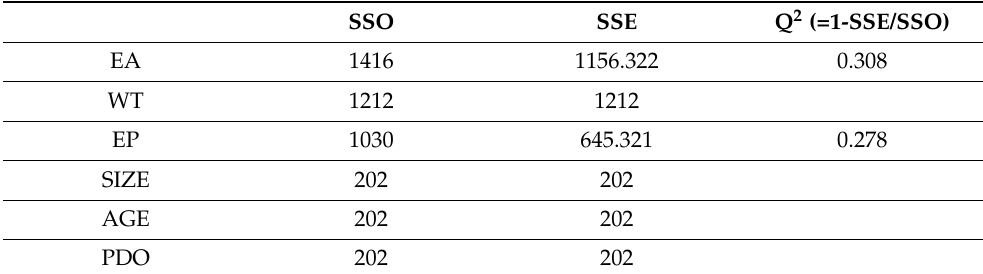
Table 8. Construct cross-validated redundancy.